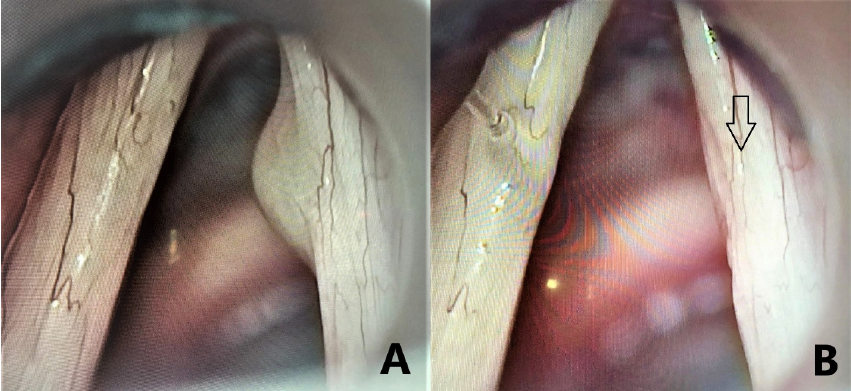
Figure 2. Suspended laryngoscopy with vocal fold cyst excision: ( A ) preoperative image of right vocal fold cyst and ( B ) postoperative image after hemostasis was obtained. The site of the injection is marked with an arrow.